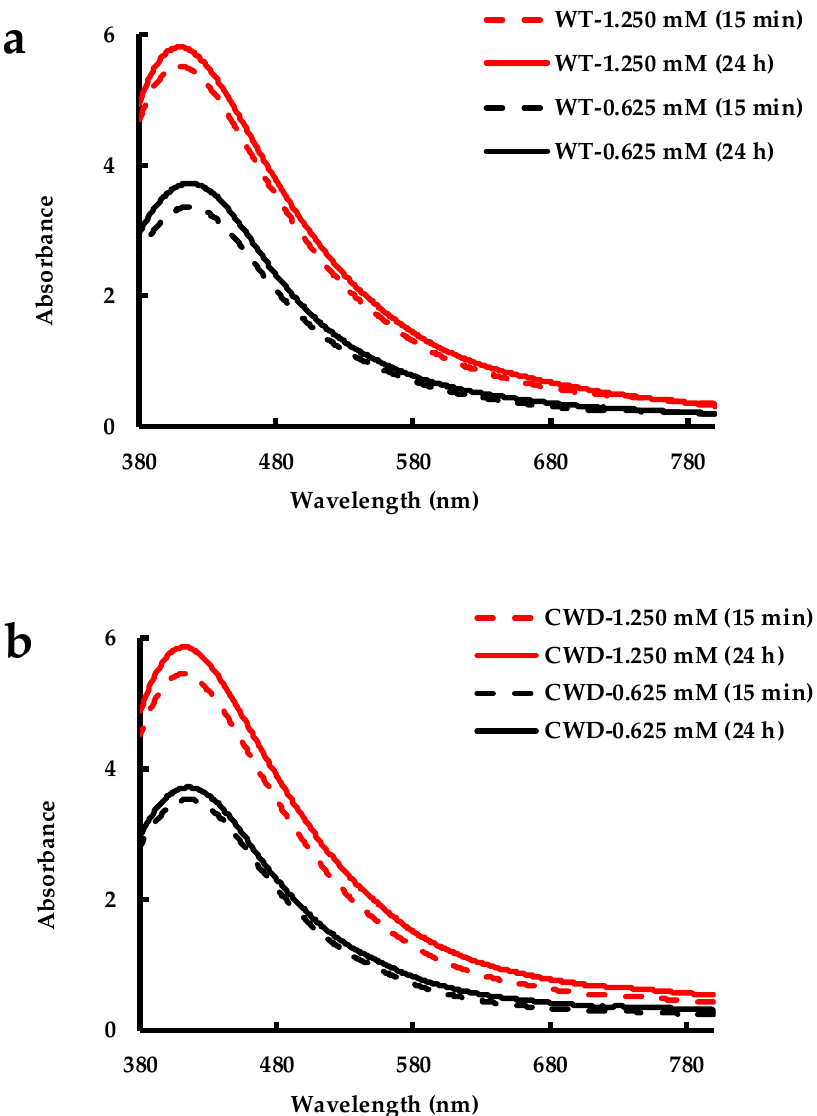
Figure 10. Stability in reagent alcohol of AgNPs produced by: ( a ) WT strain at 1.250 mM and 0.625 mM AgNO 3 concentrations; and ( b ) CWD strain at 1.250 mM and 0.625 mM AgNO 3 concentrations.